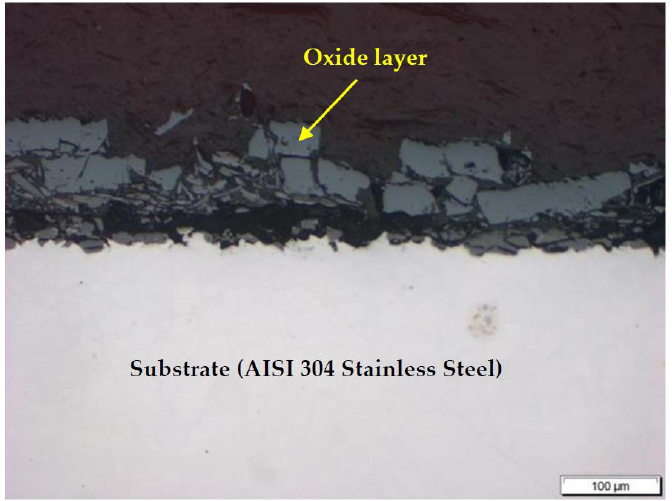
Figure 11. Micrograph corresponding to cross section of the container after tests: oxide layer.